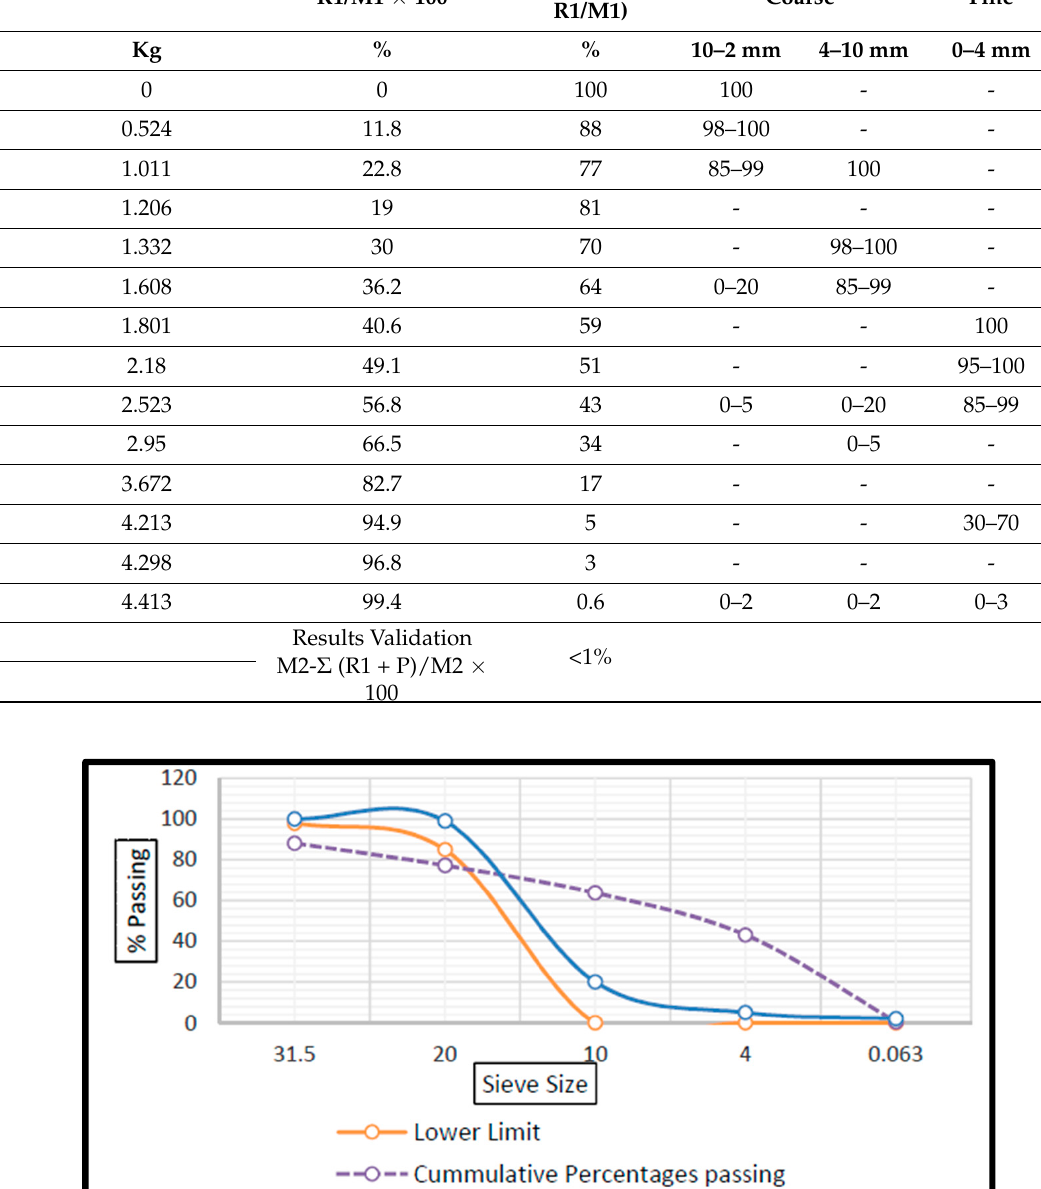
Table 2. Particle size distribution (PSD) of TBM muck as building or /road fill material according to ASTM D6913 and ASTM D1140.